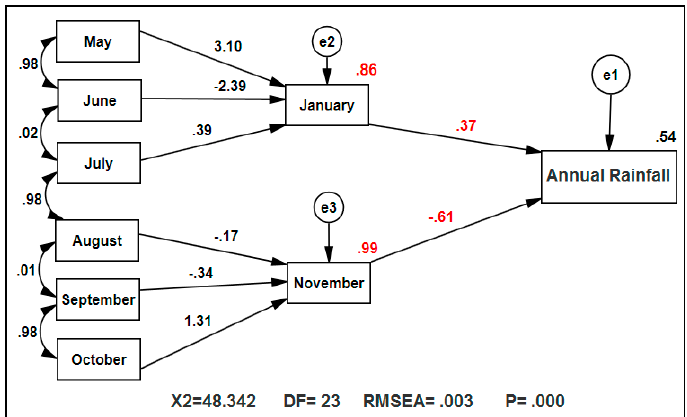
Figure 16. The effectiveness between the monthly temperature and annual rainfall (fourth model).